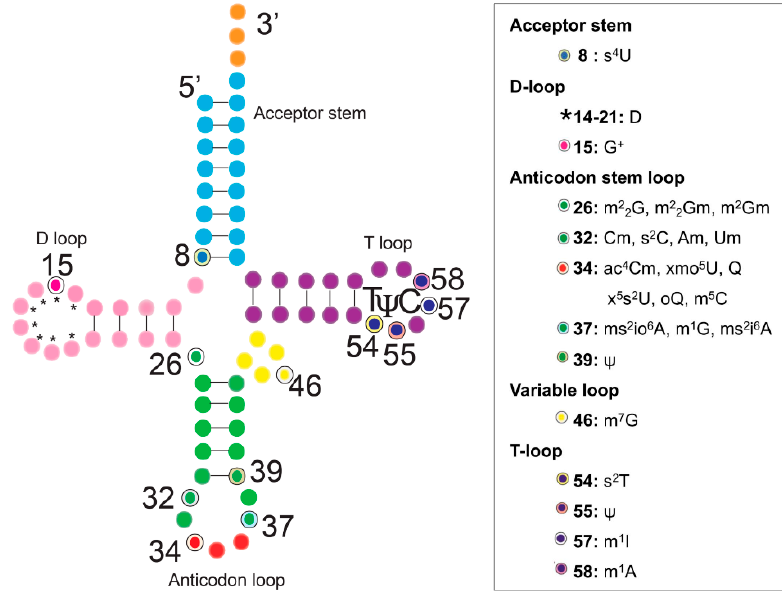
Figure 1. Schematic of the tRNA secondary structure and location of modified bases. Each structural domain of tRNA is represented in a different color and modified bases known to be affected by environmental and/or nutritional conditions are highlighted.